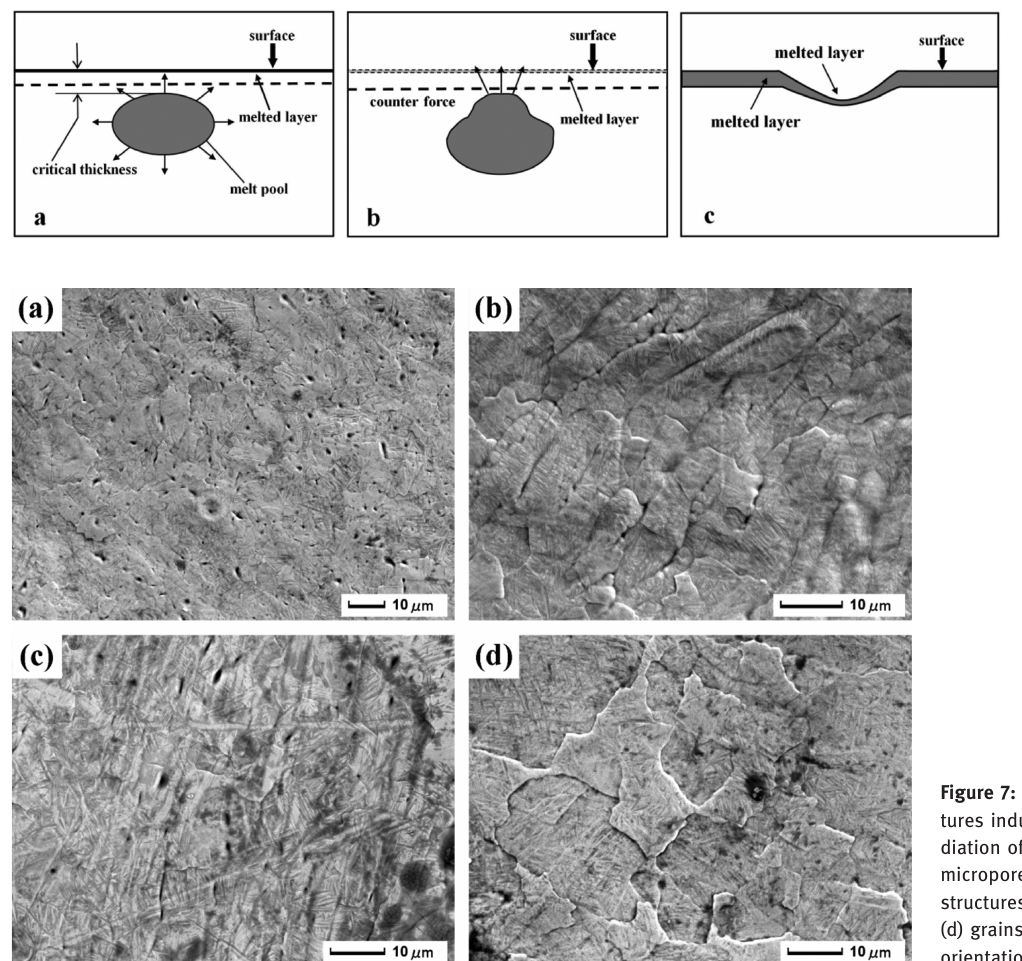
Figure 7: Deformation struc- tures induced by HCPEB irra- diation of pure zirconium (a) micropores, (b) elongated grain structures, (c) shear band and (d) grains with different crystal orientations.